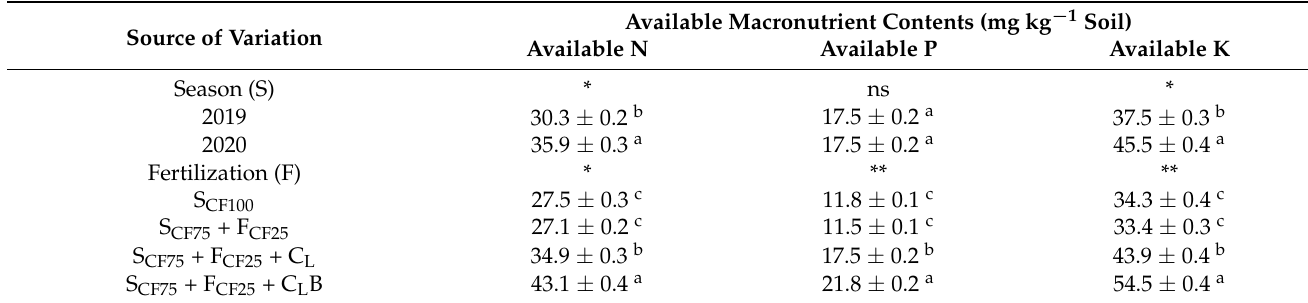
Table 3. Response of soil nutrient contents to growing season (2019 and 2020) and different fertilization strategies applied to virgin sandy